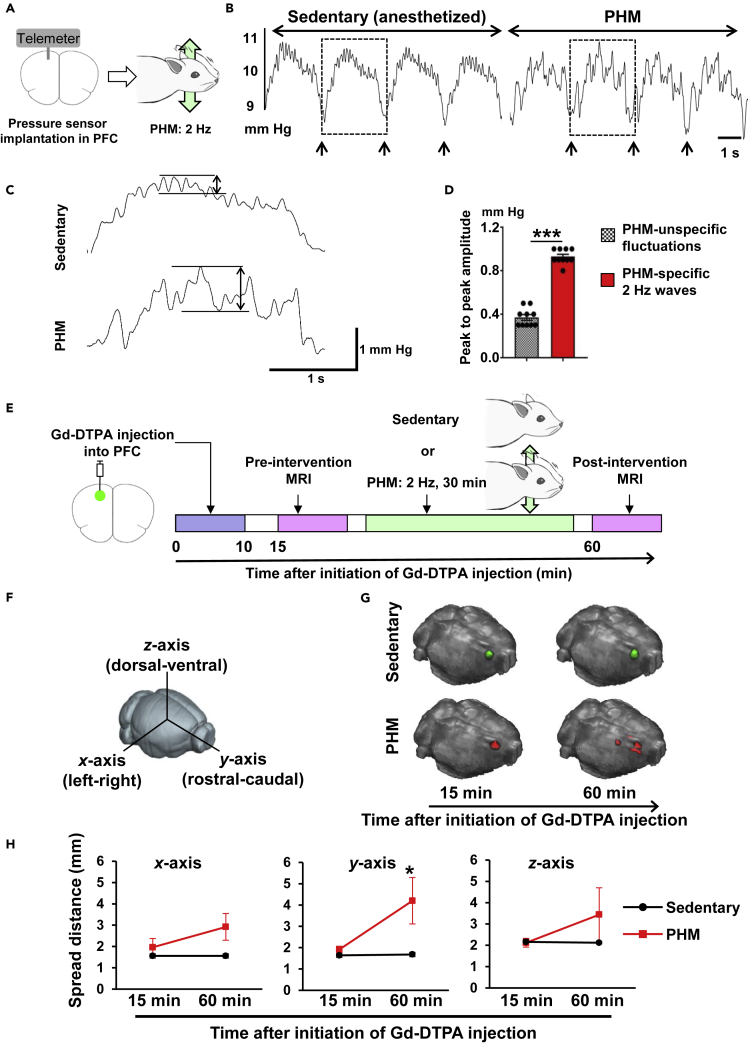
PHM Generates Intracerebral Pressure (ICP) Waves of Low Amplitude, but Facilitates Cerebral Interstitial Fluid Movement (Flow) in the PFC(A–D) PHM generated ∼1 mm Hg ICP changes. (A) Schematic representation of ICP measurement at rats' PFC. (B) Representative ICP waves recorded in rats' PFC during sedentary condition and PHM. Arrows indicate the time points of transition from inhalation to exhalation detected by simultaneous respiration monitoring. Scale bar, 1 s. Images are representative of two independent experiments with similar results. (C) Respiration-unsynchronized ICP changes. Respiration-synchronized ICP waves indicated by rectangles in (B) are presented with higher magnification. Right-angled scale bar, 1 s/1 mm Hg. Note that 2-Hz ICP waves indicated by a two-headed arrow were specifically generated during PHM. (D) Magnitude of PHM-specific and PHM-unspecific ICP changes unsynchronized with respiration. Peak-to-peak magnitudes indicated by two-headed arrows in (C) were quantified. Data are represented as means ± SEM. ***p < 0.001 (unpaired t test, 10 segments analyzed for each).(E–H) PHM facilitates cerebral interstitial fluid movement (flow). (E) Schematic representation of experimental protocol for magnetic resonance imaging analysis of Gd-DTPA injected in rats' PFC. (F) Definition of x (left-right), y (rostral-caudal), and z (dorsal-ventral) axes used in this study. (G) Representative Gd-DTPA spreading presented on a surface-rendered brain. Gd-DTPA clusters are indicated by green (sedentary) and red (PHM). Images are representative of five rats. (H) Quantification of Gd-DTPA spreading along each axis. Red line: PHM (n = 5), black line: sedentary (n = 5). Data are represented as means ± SEM. *p < 0.05 (x axis: p = 0.065, y axis: p = 0.049, z axis: p = 0.33, unpaired t test).See also Figures S5 and S6, and Table S1.